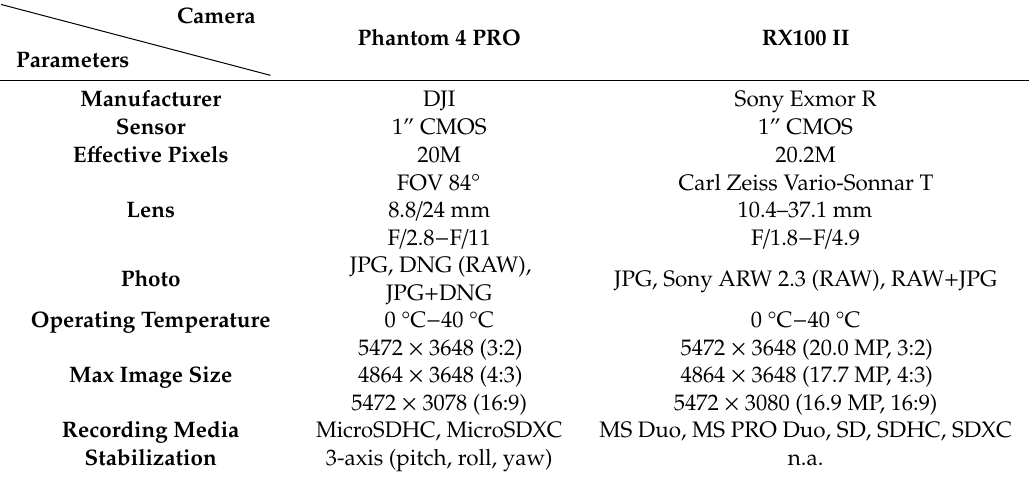
Table 2. DJI and Sony RX100 II cameras technical specification.